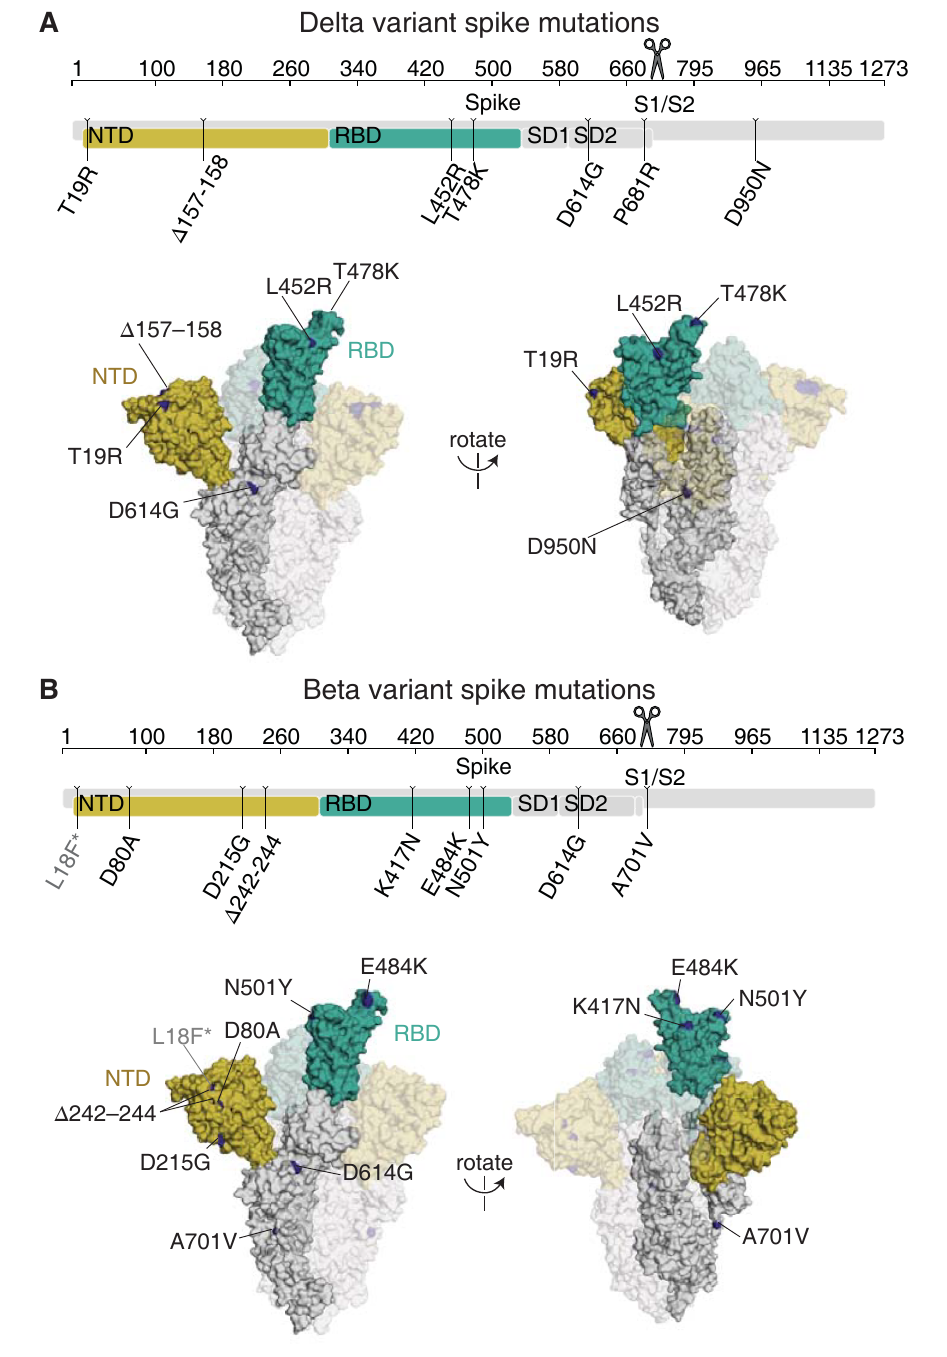
Fig 1. Delta and Beta spikes contain mutations in multiple domains. (A,B) Mutations in the Delta (A) or Beta (B) spikes relative to Wuhan-Hu-1 [6,26]. Sites where mutations occur in the spike ectodomain are highlighted in dark blue on the Wuhan-Hu-1 one-RBD open spike trimer (PDB 6ZGG) [63]. The surface of one spike monomer is shown; the other two protomers are transparent. Visualization of linear spike sequence modified from https://covdb.stanford. edu/sierra/sars2/by-patterns/. Scissors icon by Mario Verduzco from